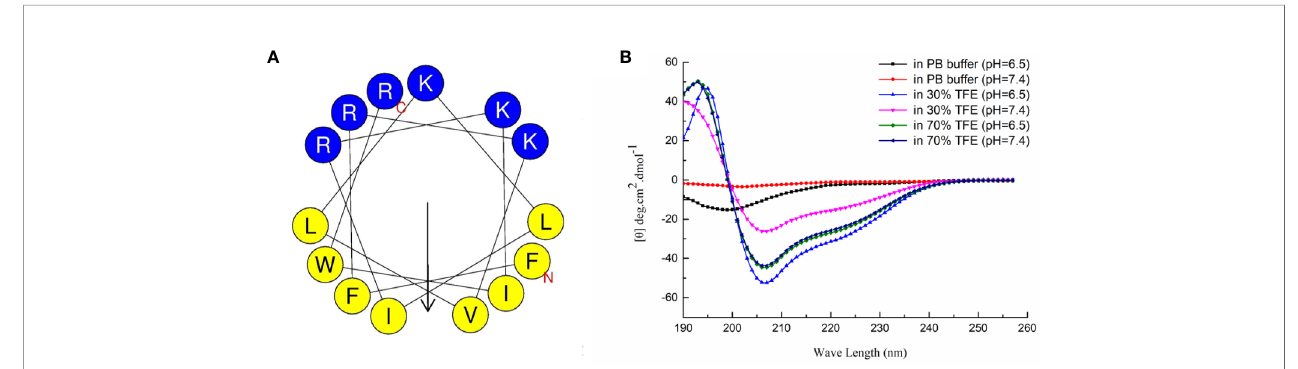
FIGURE 1 | Secondary structure analysis of HX-12C. (A) The secondary structure of HX-12C was a typical amphiphilic structure. The hydrophobic amino acid residues and hydrophilic residues are distributed on both sides of the helix. (B) The circular dichroism analysis structure of HX-12C. In the PB buffer, the coil is irregular, while in the presence of a cosolvent, it forms a typical spiral structure (Luo et al.,